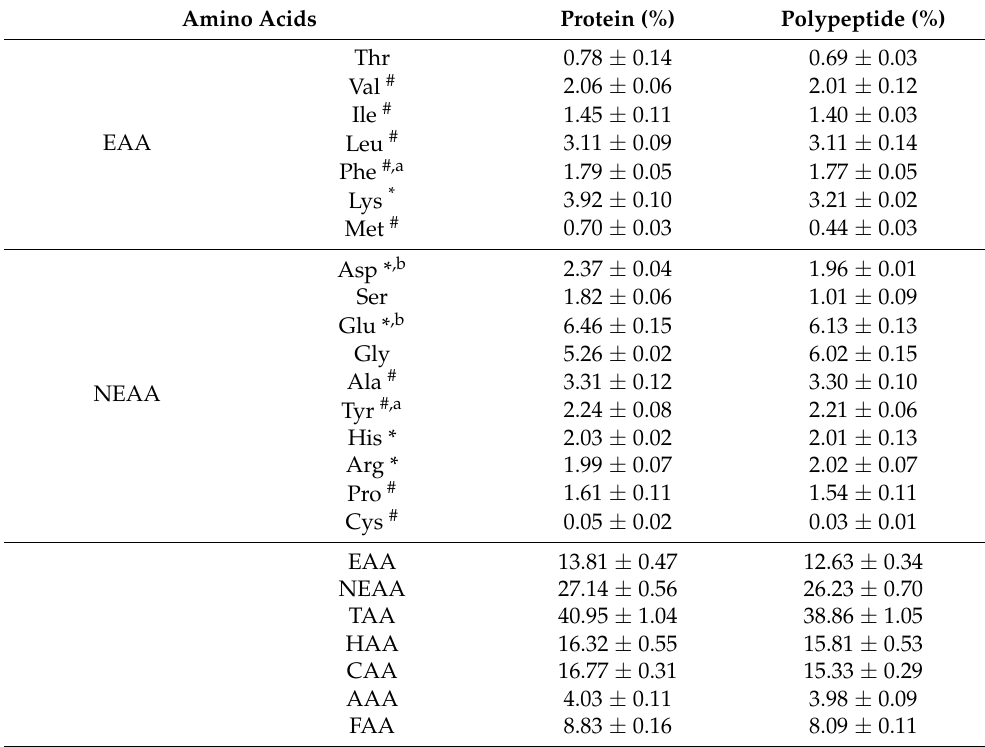
Table 6. Amino acid composition of protein and polypeptide of WBY. Amino Acids Protein (%) Polypeptide (%)